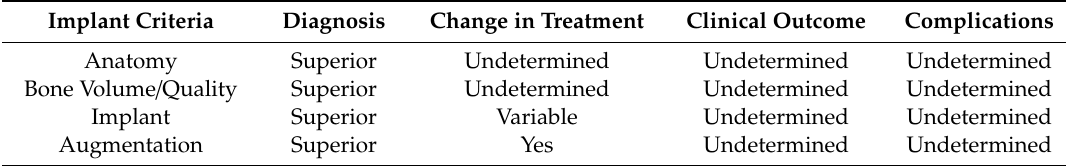
Table 2. Comparison of Cone Beam Computed Tomography to Panoramic Imaging in Dental Implant